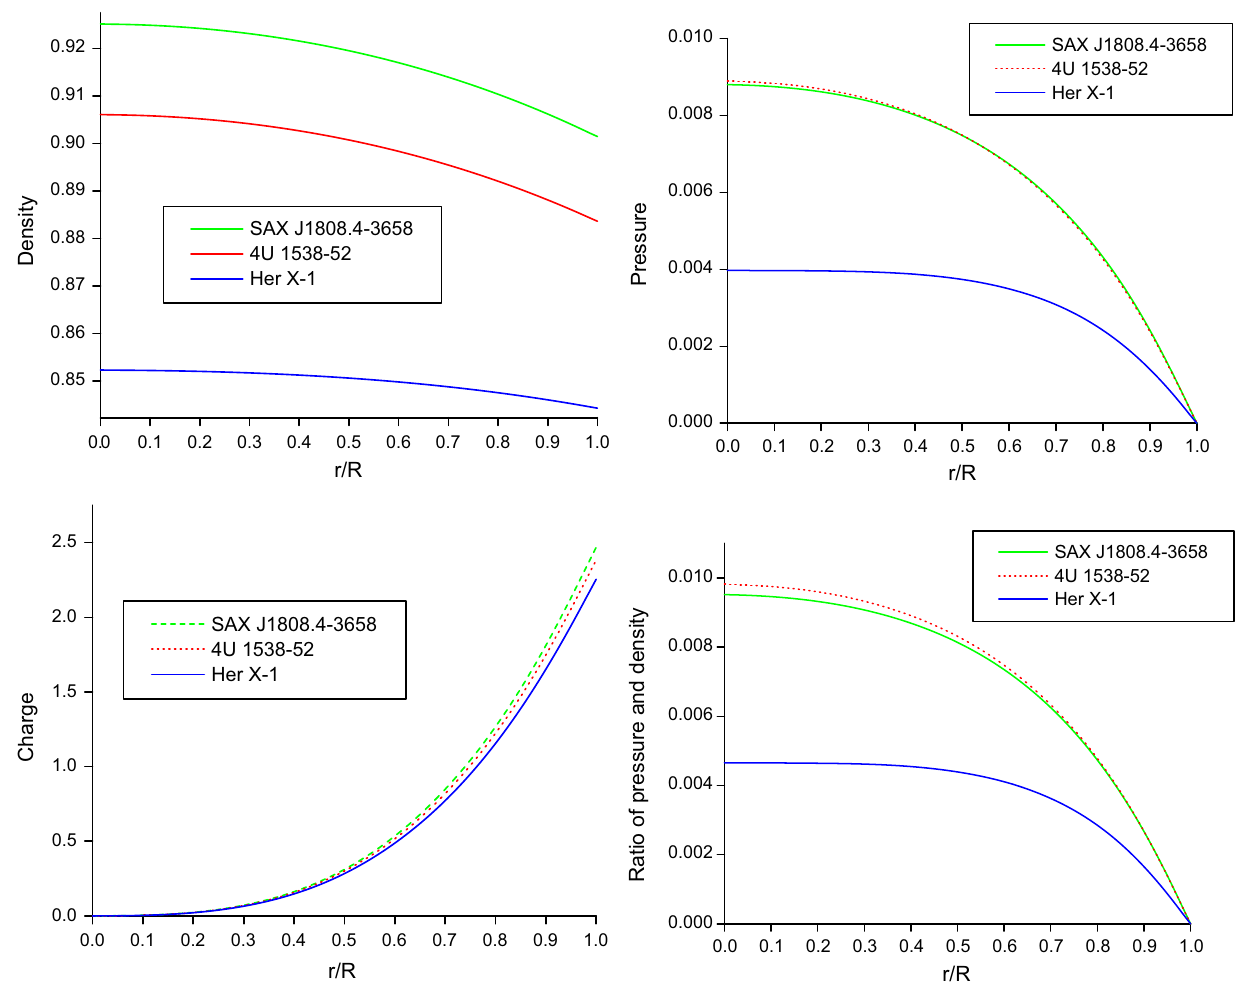
K = 0 . 0032 , b = 0 . 01 , C 1 = − 0 . 00099, β 2 = 1.006 M = 0 . 9 M (cid:6) ,